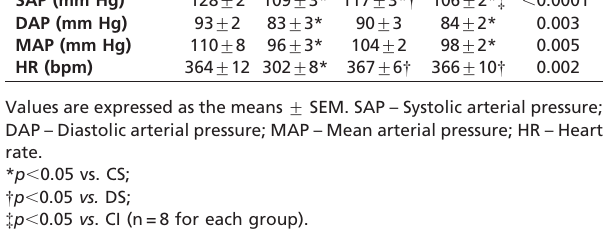
Table 2 - Hemodynamic parameters in control sham (CS), diabetic sham (DS), control infarcted (CI), and diabetic infarcted (DI) groups.